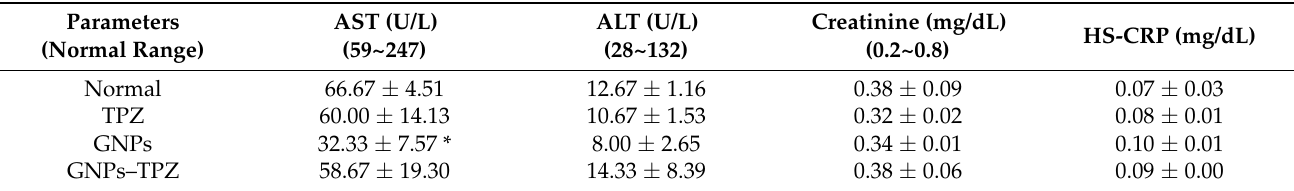
Table 1. Biochemical and inflammatory activity in liver and kidney